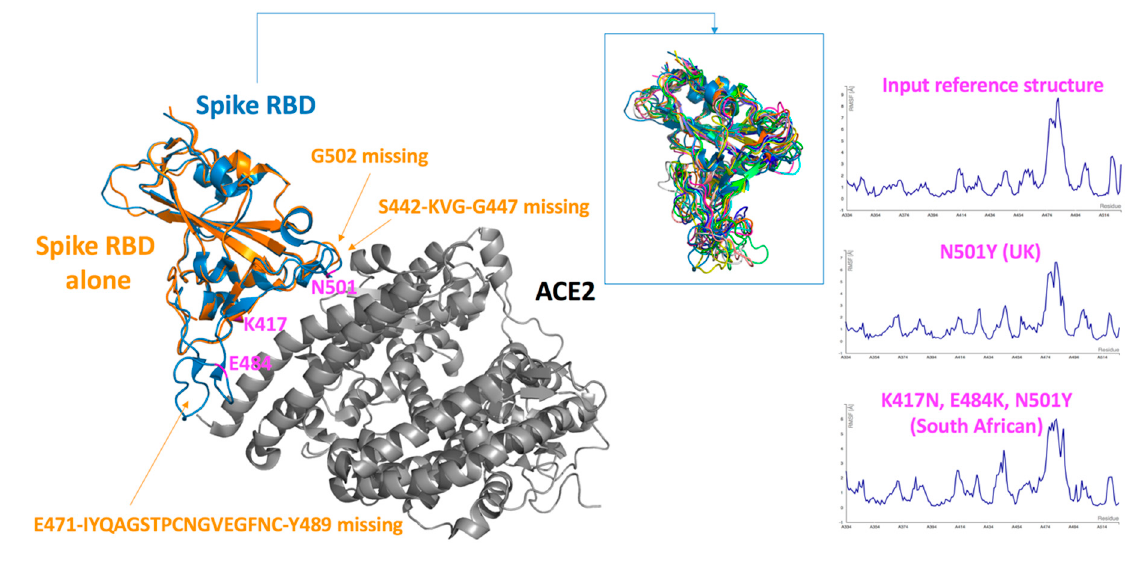
Figure 3. Analysis of the Spike receptor-binding domain (RBD) in a simulated unbound state. (Left) The Spike RBD domain as seen in complex with ACE2 (in grey) is shown in blue (PDB entry 6M0J). The Spike RBD 3D structure as defined in the absence of the ACE2 receptor (PDB entry 6VYB) is shown in orange. The amino acids of interest for this study are in magenta. It is seen that some loops are not fully defined in 3D when the Spike protein is crystallized in the absence of the ACE2. These loops should thus be relatively flexible in solution. As residues 501 and 484 are located in these peptide segments, it was important to predict the possible structural changes in the RBD in the unbound state. The 3D structure of the RBD as found in the PDB entry 6M0J was selected (the ACE2 atoms were deleted) and used as input for the simulations. In the inset, middle of the figure, one can see ten representative structures of the simulated nonmutated RBD input structure (there are no major differences when visualizing the variants). All the models are superimposed on the input structure (cartoon diagram, painted in blue) and then each model has a different color. One notices that some loops are flexible, the most important structural changes when removing the ACE2 structure occur in the loop involving residues 471 to 489. This loop should adopt several conformations in solution, and be stabilized upon binding to the ACE2 (and most likely when interacting with some antibodies). (Right) The fluctuation plots (RMSF in Å) obtained for the Spike RBD without substitution, the N501Y variant and the K417N, E484K, N501Y variant are shown. These three proteins have the same overall RMSF profiles, with some small changes that differ in the South African strain as compared to the initial input structure or to the UK strain. This suggests that the 3D structures of this domain of the Spike should be resilient to such amino acid changes in term of conformational changes. In addition, we do not expect these replacements to destabilize the unbound Spike protein suggesting that many of the effects seen for these variants could be due to affinity changes toward ACE2 (see